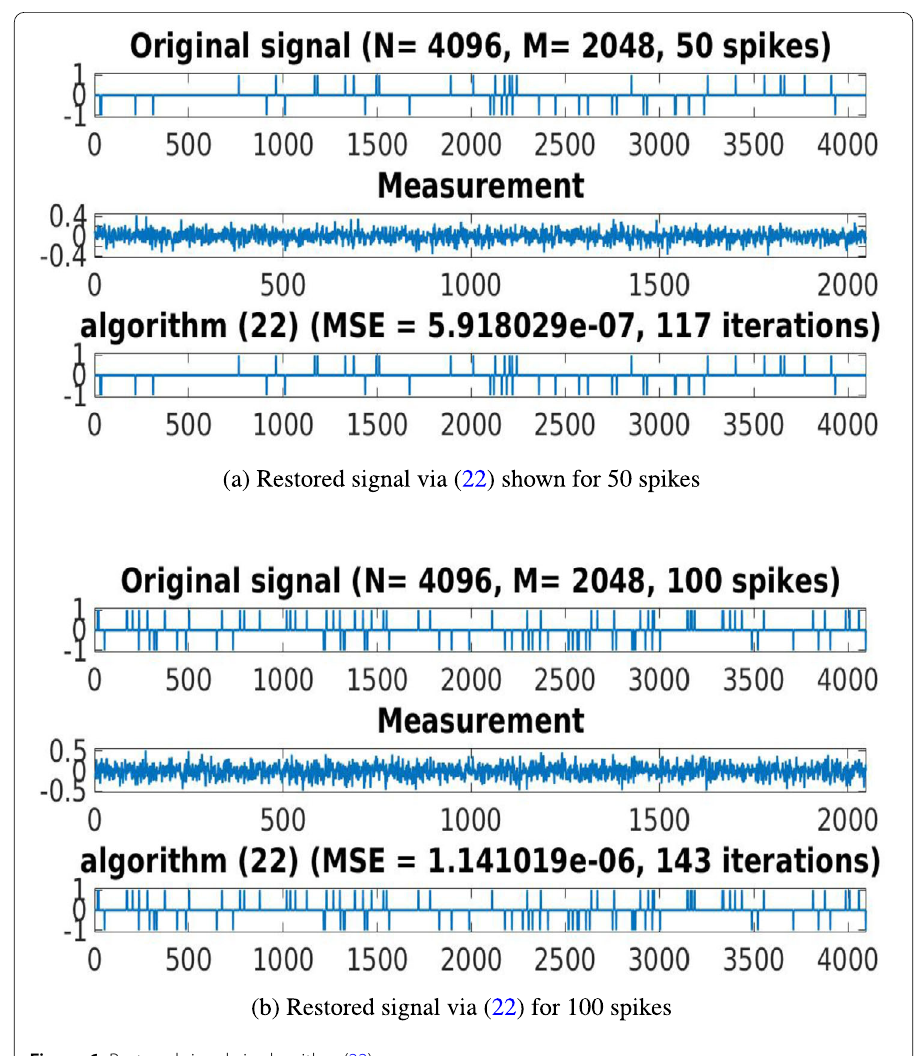
Figure 6 Restored signal via algorithm (22)